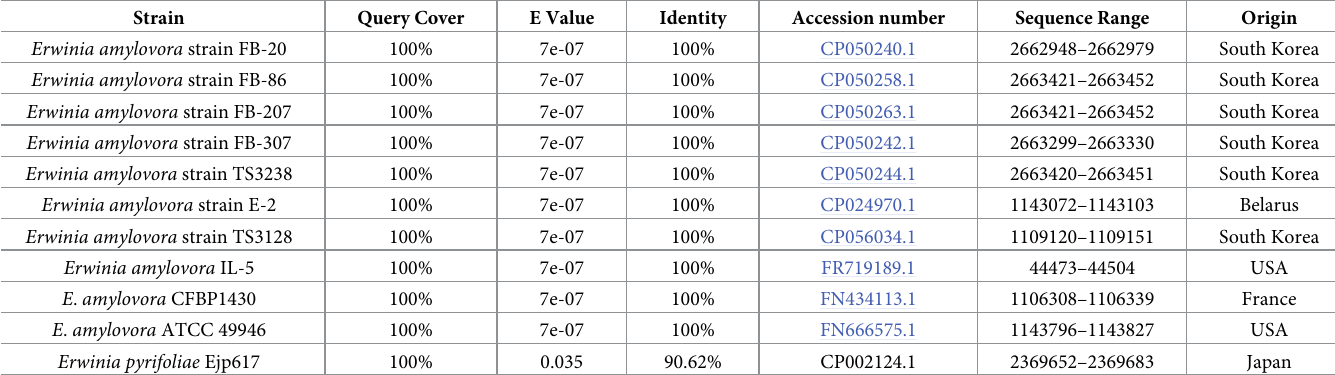
Table 3. BLASTn results of the nucleotide sequence of the novel spacer. Strain